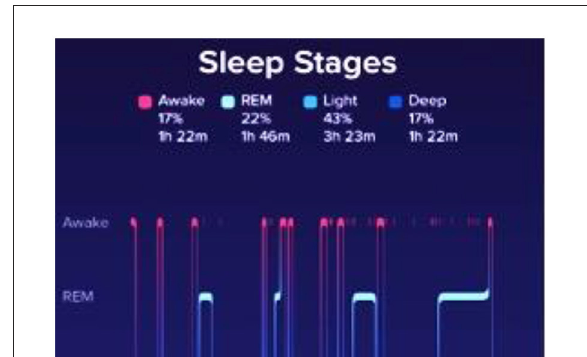
FIGURE3 Fitbit watch (wearable sensor).